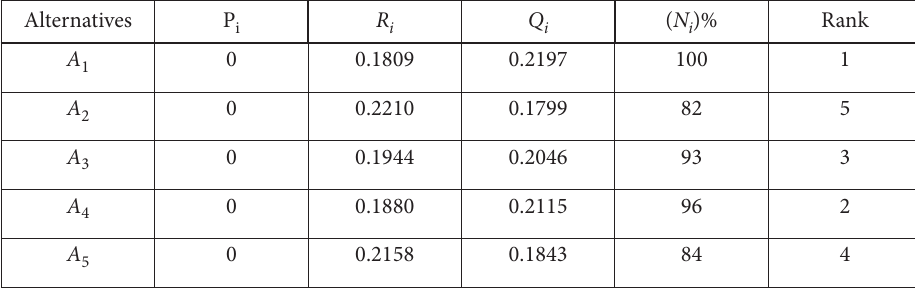
Table 11. Decision results according to a COPRAS-G